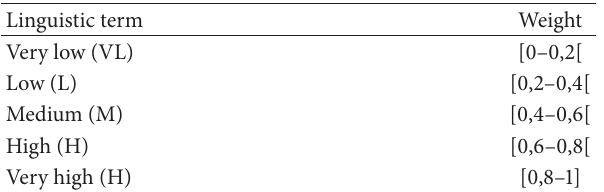
Table 4: Linguistic variables for the importance weight of each criterion.